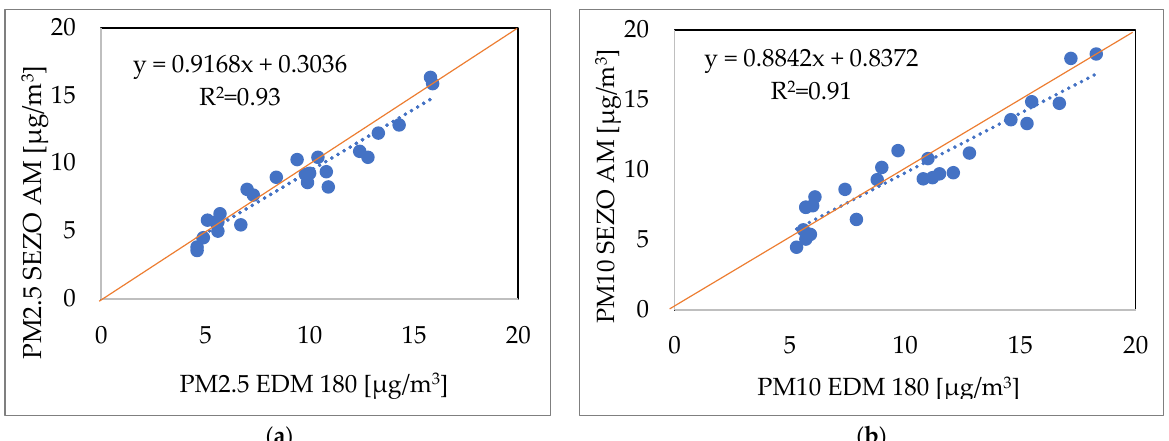
Figure 14. Relationship between the hourly concentration values measured on 23 February 2022 with the SEZO AM with modified inlet and correction factor and EDM 180 analyser for ( a ) PM2.5 and ( b ) PM10. Positive (Direct) Relationship is marked with the red line.